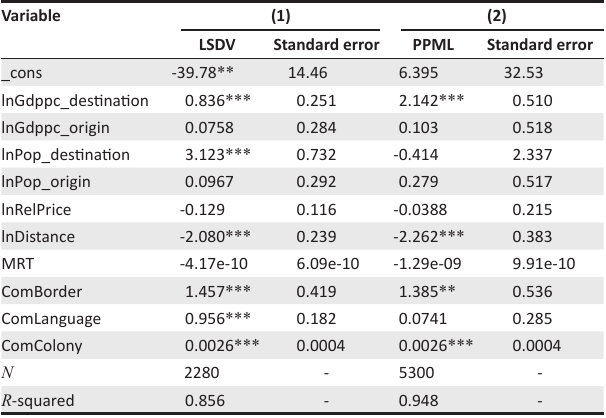
TABLE 1: Results of the gravity model.